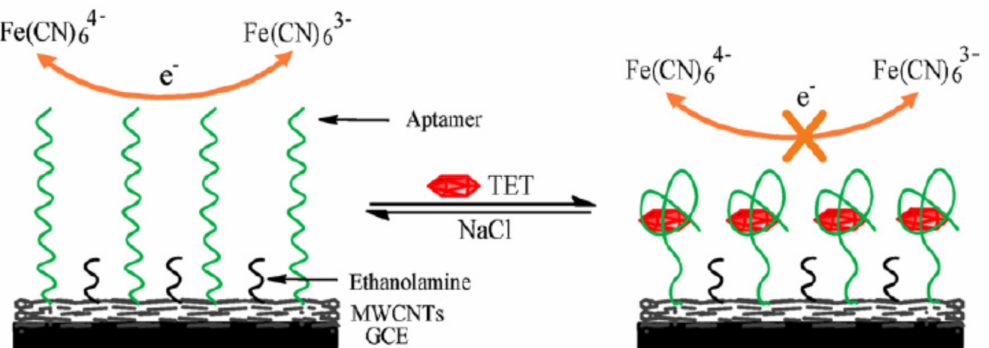
Figure 13. Fabrication of aptasensors modified with multi-walled carbon nanotubes (MWCNTs). Reprinted from reference [133]. with permission from